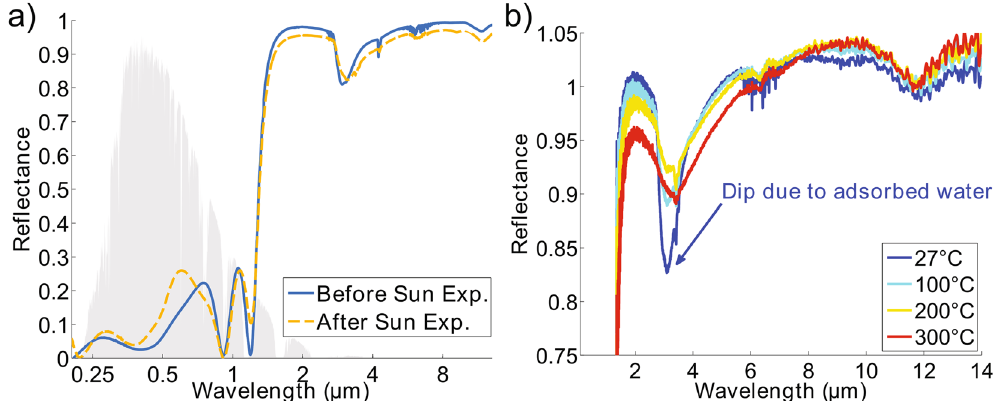
Figure 3. ( a ) Measured reflectance of sample versus wavelength before and after 4 temperature cycles under the sun and 2 cycles under an AM1.5 G solar simulator. The solar spectrum, shown in gray, ranges from 0.28 μ m to 2.5 μ m, and thermal wavelengths extend beyond 3 μ m. Only slight changes in the optical properties are observed after multiple cycles. ( b ) Infrared reflectance versus wavelength at various temperatures. The sharp dip in reflectance at room temperature is primarily due to adsorbed water on the sample surface that evaporates at elevated temperatures. The reflectance exceeds unity due to an absolute uncertainty in the measurement of around 5%.